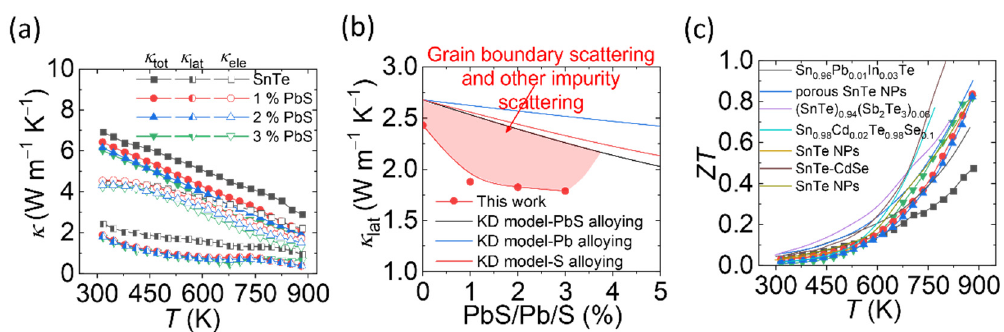
Figure 7. ( a ) The thermal conductivity as a function of temperature; ( b ) the lattice thermal conductivity as a function of Pb content; ( c ) ZT as a function of temperature. The SnTe references are listed in SI.